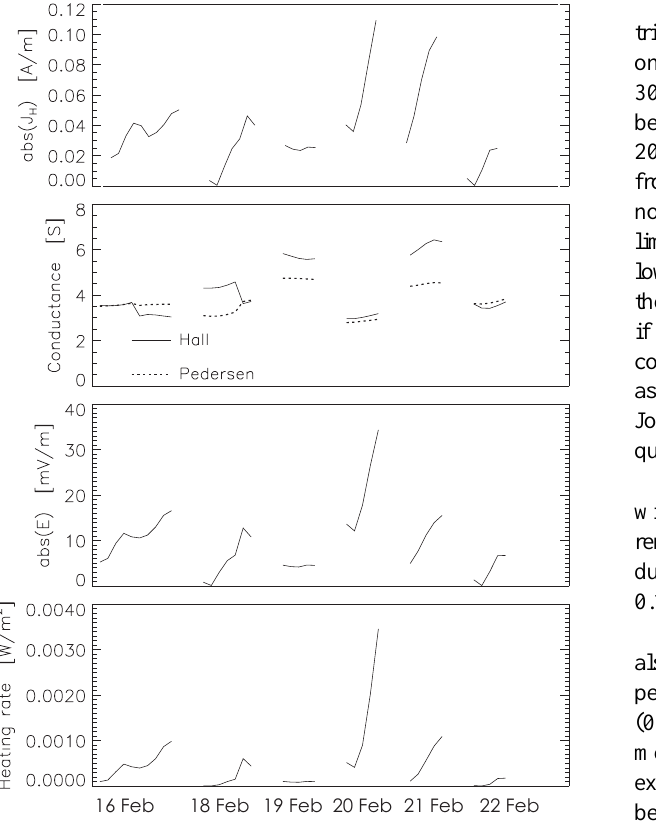
Fig. 11. Several quantities for the time interval when CHAMP was within the area 70 ◦ < geogr. lat. < 75 ◦ , 0 ◦ < geogr. long. < 40 ◦ on six days of the SIRCUS campaign (16–22 February 2002). Upper panel: Hall current from the CHAMP magnetometer, second panel: conductances derived from EISCAT VHF data, third panel: magni- tude of the electric field obtained from Eq. (4), fourth panel: Joule heating rates obtained from Eq.